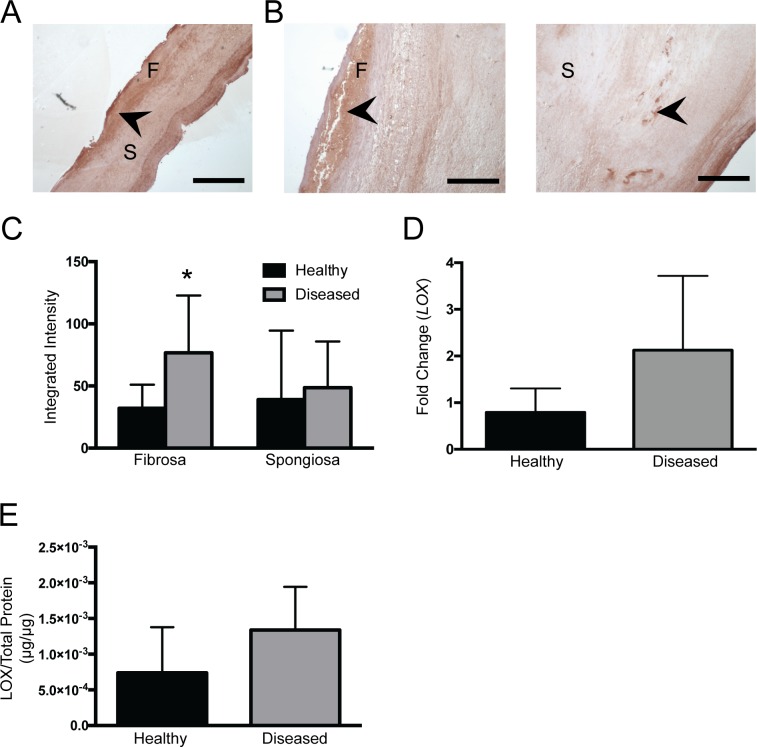
Immunohistochemical detection and quantification of lysyl oxidase (LOX) expression.Immunohistochemical staining of (A) healthy and (B) diseased leaflets shows distribution of LOX production throughout leaflet, with some areas of localized high-intensity staining (indicated by arrows). F = fibrosa, S = spongiosa. N = 5. Scale bar = 0.50 mm. (C) Layer-specific quantification of LOX staining, indicating significantly greater amounts of LOX in the diseased fibrosa relative to the healthy condition (p = 0.001728). N = 5, n = 3. Total LOX expression across the entire leaflet was also quantified via (D) qRT-PCR for LOX (N = 5, n = 3) and (E) measurement of LOX protein via dot blot (N = 5, n = 3).